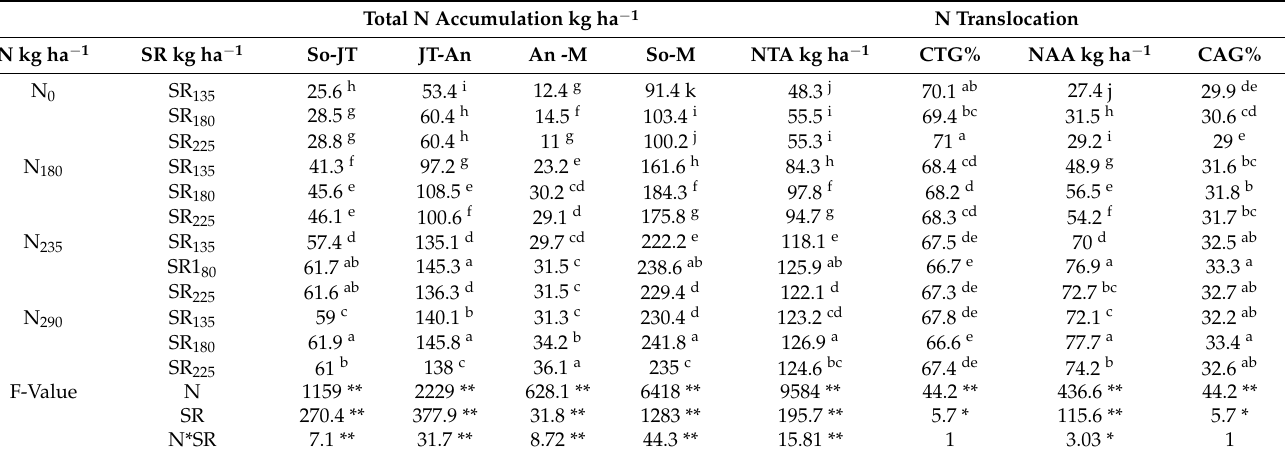
Table 4. Combination effects of N and SR on total N accumulation and translocation in 2018–2019.